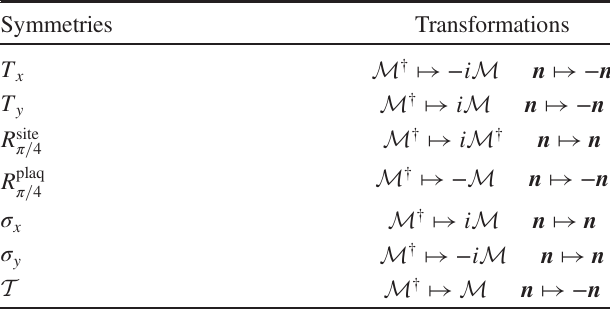
TABLE V. Transformation of the monopole operator M and N´eel vector n in the field theory of the nonlinear sigma model in the N´eel order phase.